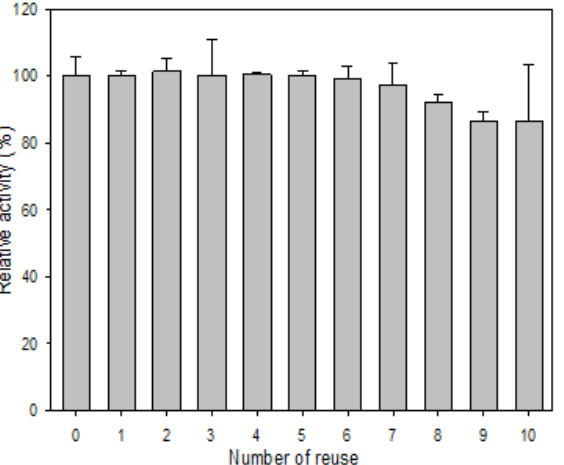
Figure 7. Reusability of R5-SazCA-SP. The initial CO 2 hydratase activity was set as 100%. After each reaction cycle, R5- SazCA-SP was collected by centrifugation at 10,000× g at 4 °C for 5 min, followed by washing with 2 mL of storage buffer twice.